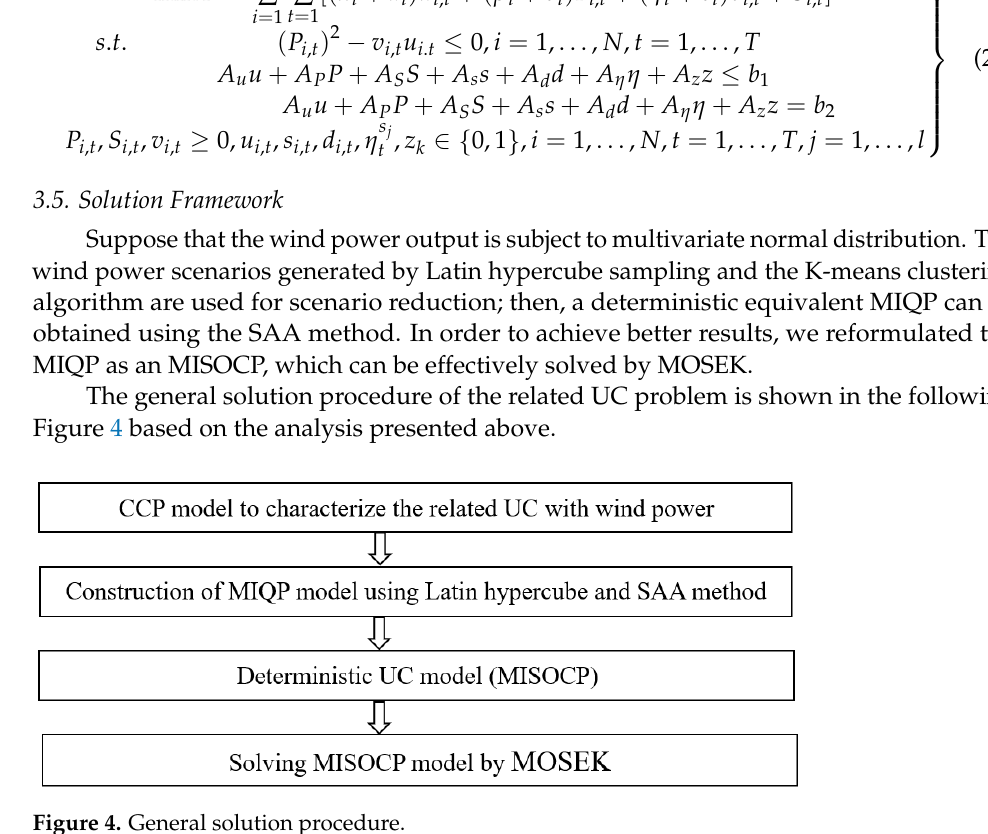
Figure 4. General solution